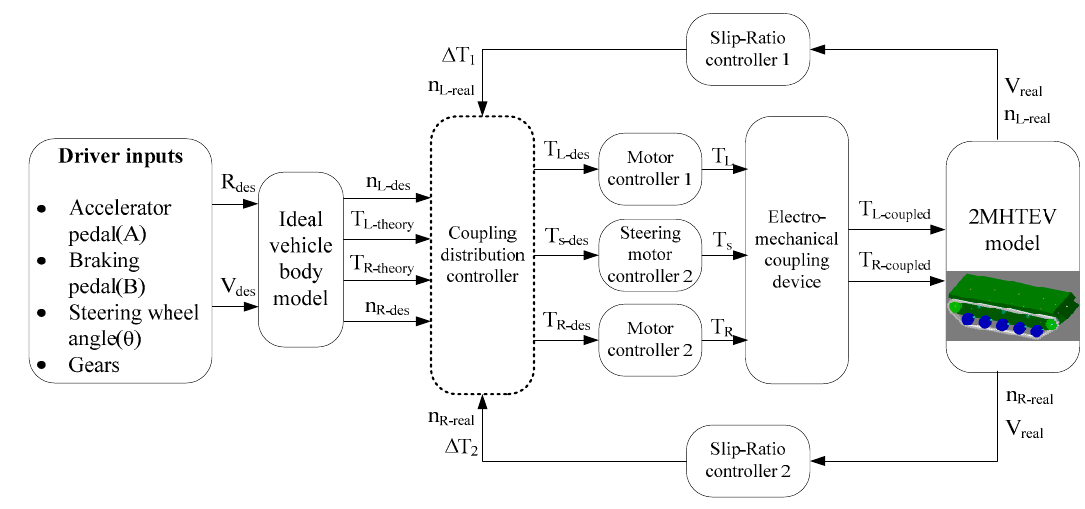
Figure 6. Torque distribution strategy based on speed.